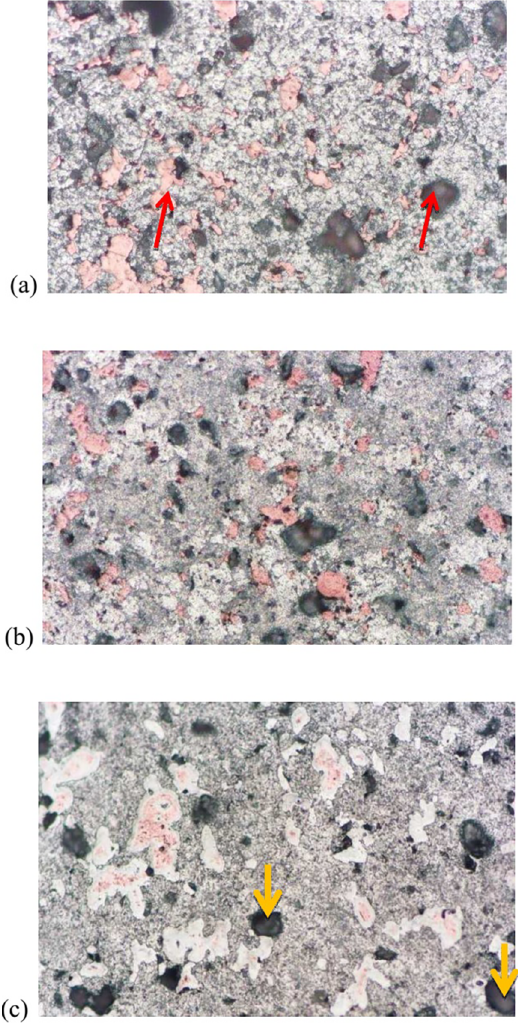
Figure 3. Optical micrographs of etched Aluminium compacts sintered in) Al-20%Cu-15%Mn (a) Conventional Sintering; (b) Microwave Sintering; (c) Spark Plasma Sintering